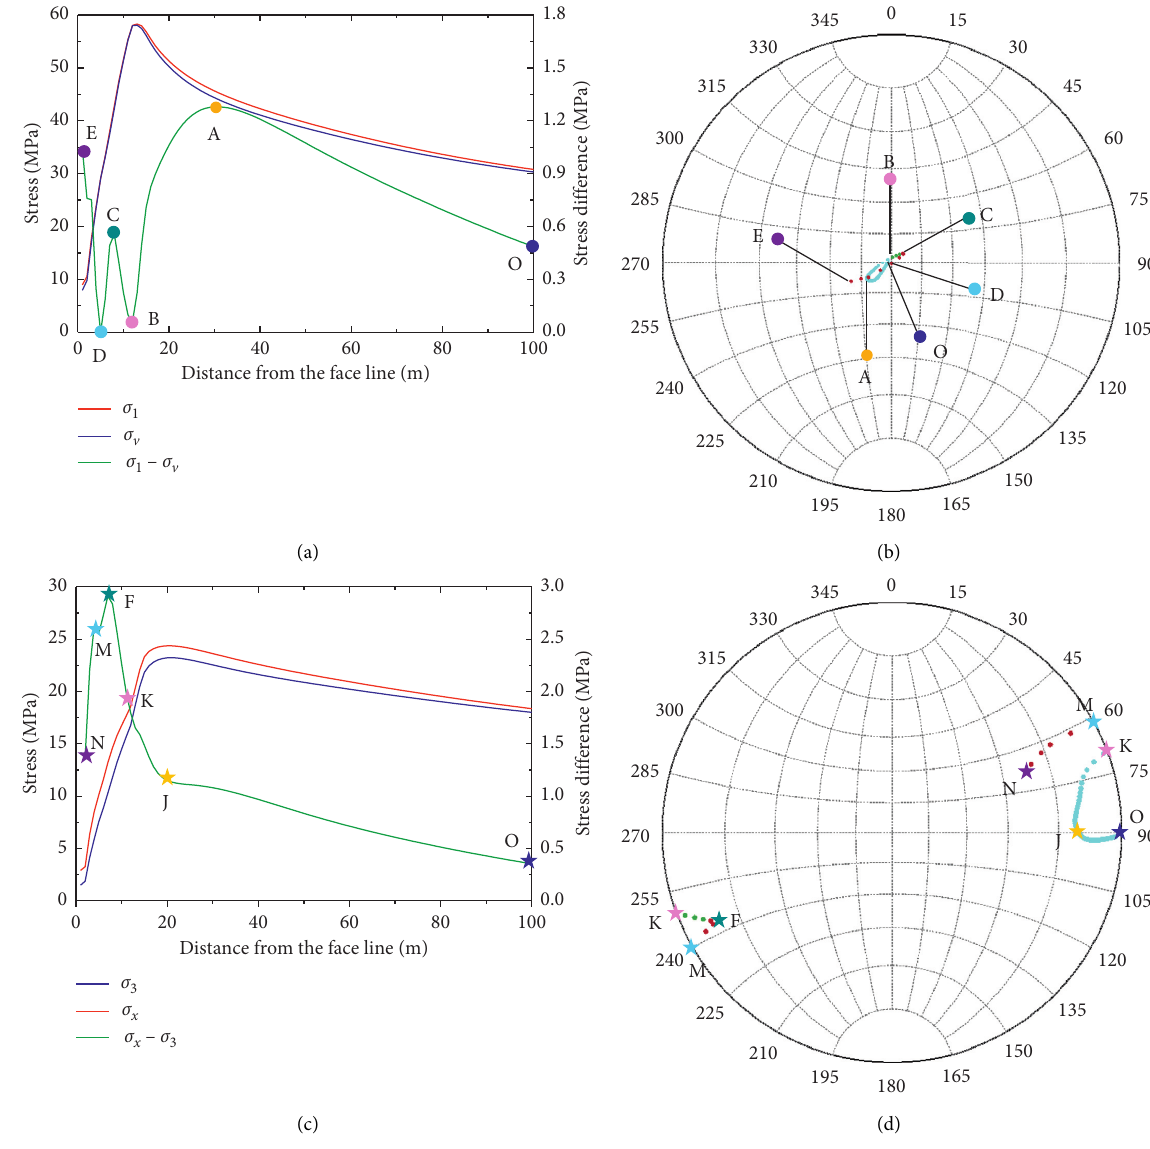
Figure 11: Stress rotation along the monitoring line. (a) Difference between the major principal and vertical stresses. (b) Rotation trace of the major principal stress. (c) Difference between the minor principal and x -axial stresses. (d) Rotation trace of the minor principal